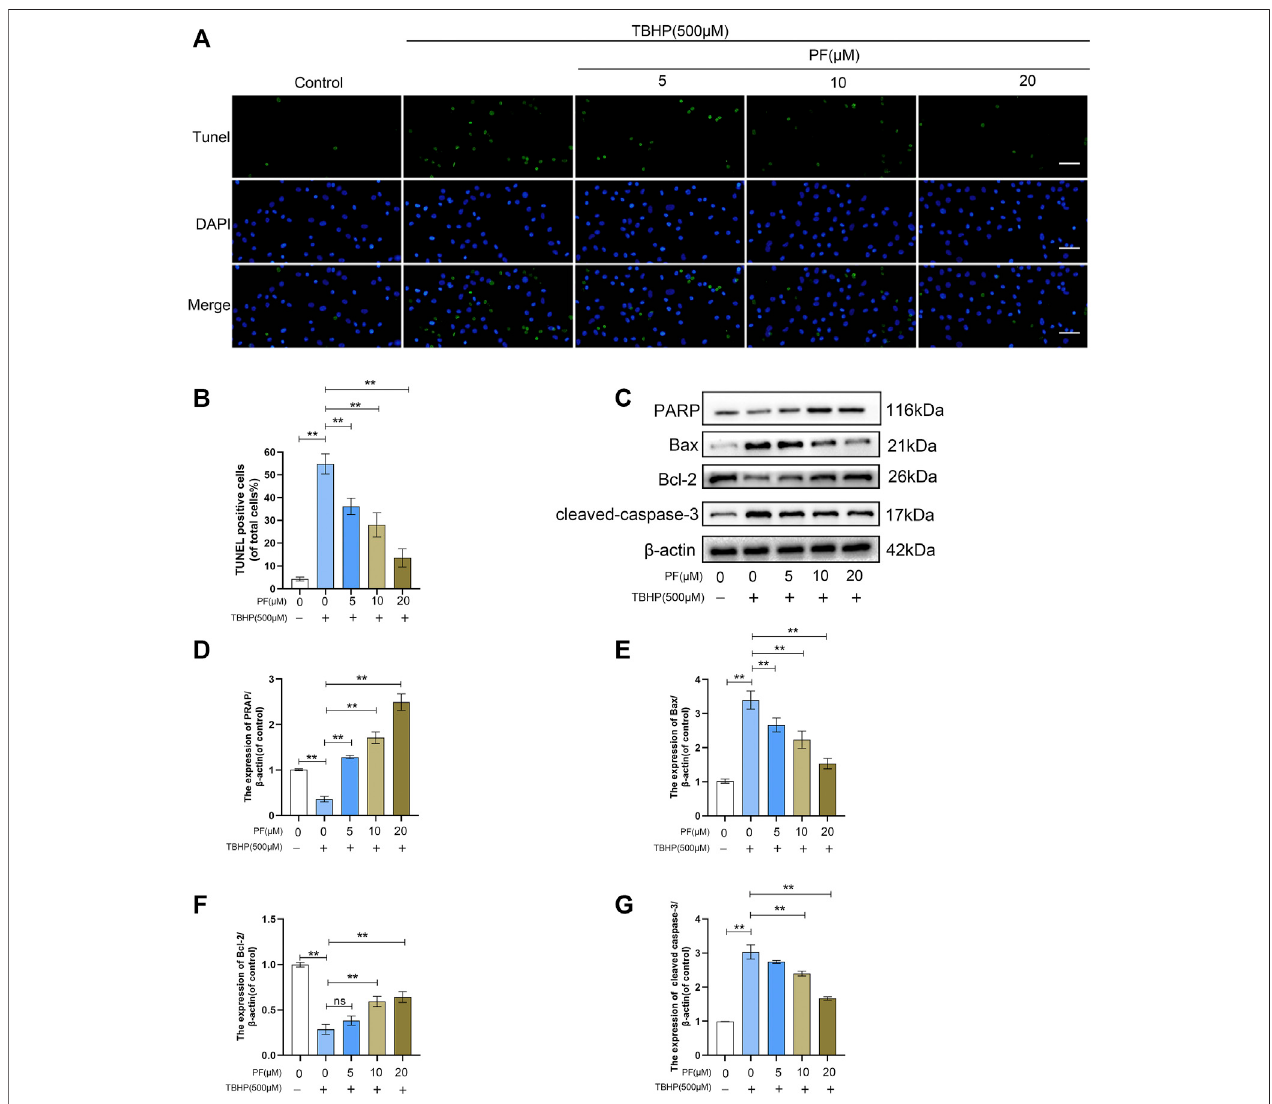
FIGURE 2 | Paeoni fl orin (PF) alleviated TBHP-induced apoptosis in HUVECs. (A) Evaluation of DNA damage (scan bar, 100 μ m) (nuclei, blue; positive cells, green) using TUNEL assay. (B) Histogram shows the proportion of TUNEL positive cells. (C – G) Evaluation of poly (ADP-ribose) polymerase (PARP), Bax, Bcl-2, and cleaved caspase-3 levels in HUVECs under different treatment conditions using Western blotting. Data: mean ± SD, * p < 0.05 and ** p < 0.01. n (cid:2) 3.